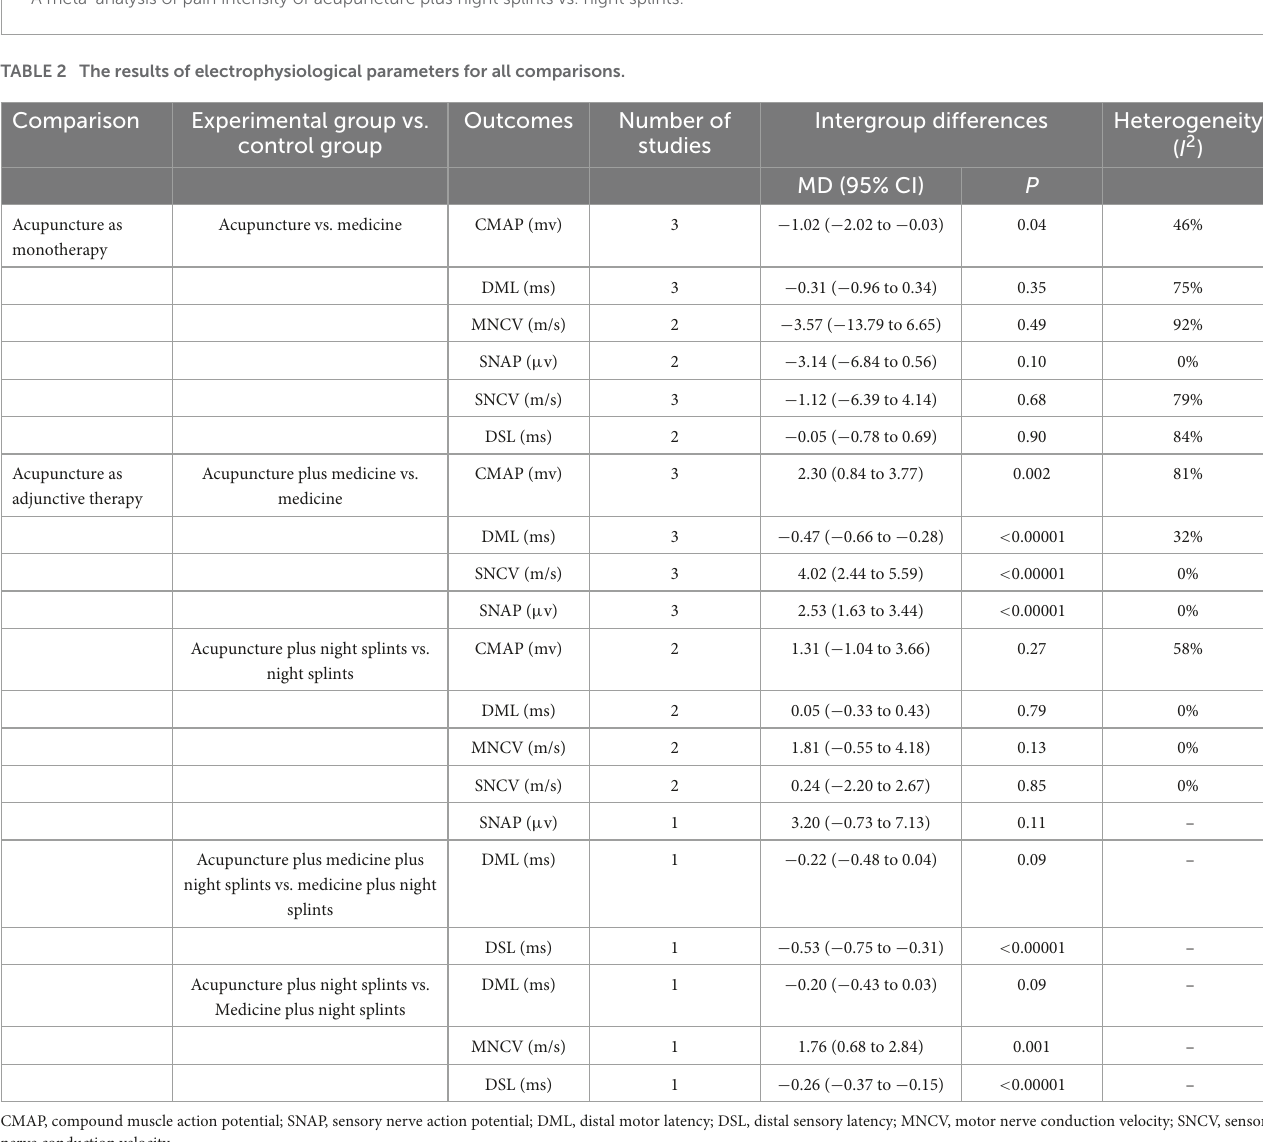
FIGURE7 A meta-analysis of pain intensity of acupuncture plus night splints vs. night splints.